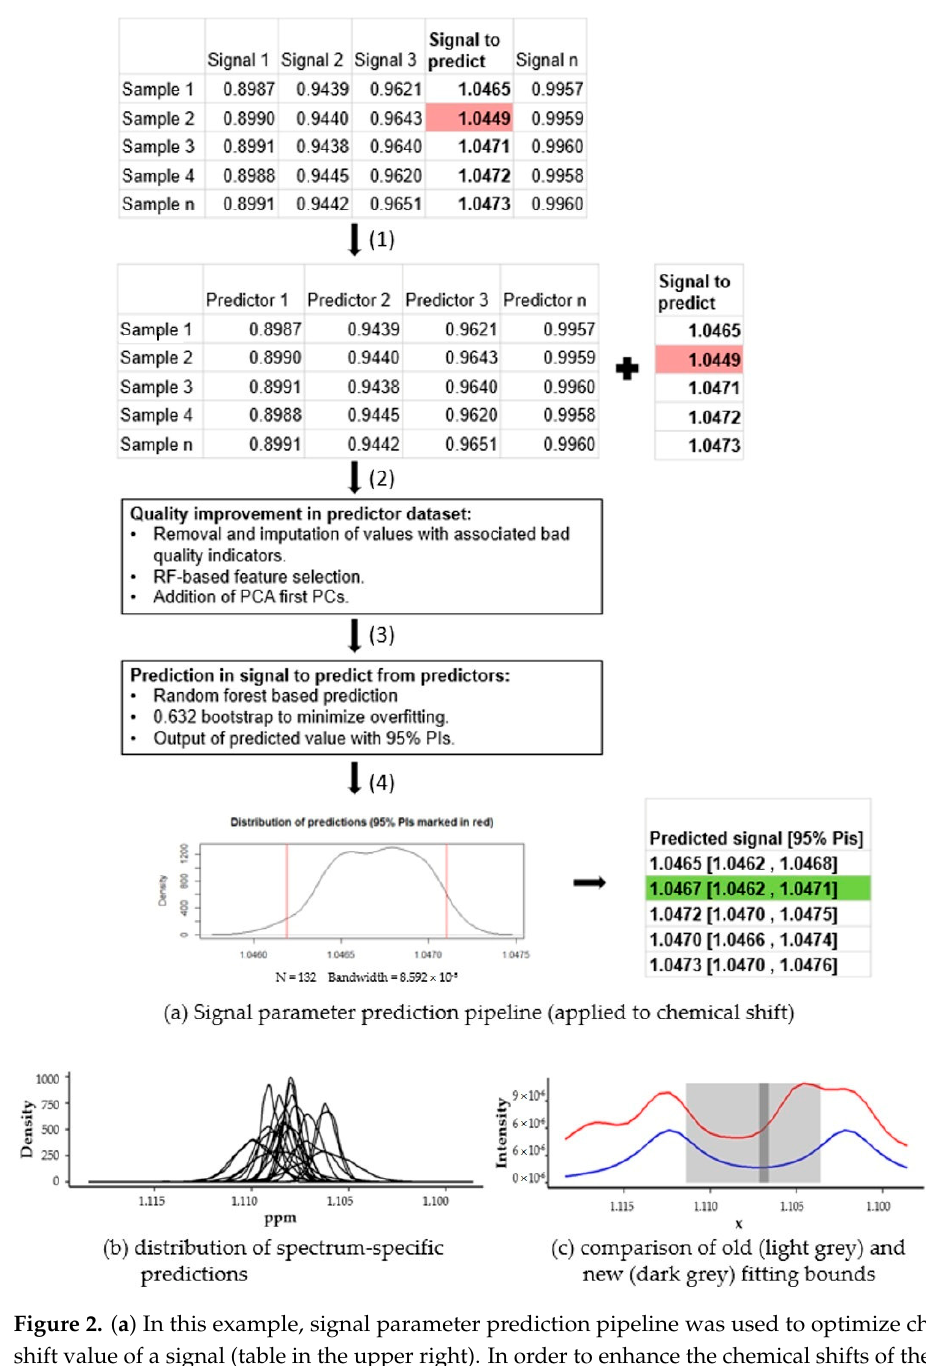
Figure 2. ( a ) In this example, signal parameter prediction pipeline was used to optimize chemical shift value of a signal (table in the upper right). In order to enhance the chemical shifts of the signal in question, a training dataset was built, excluding the signal to predict ( a , 1 ). The dataset is then cleaned, filtered, and enriched to maximize its prediction quality ( a , 2 ). The information from the first iteration was used to train a prediction model. During training, bootstrap resampling was used to avoid overfitting inaccurate values ( a , 3 ). For each predicted chemical shift, the distribution of the predictions made during the bootstrap iterations was built and the median value and 95% PIs of this distribution were outputted ( a , 4 ). After optimization, the predicted value and PIs are shown in the bottom right table; in this case, an inaccurate chemical shift, shaded in red, was clearly outside the 95% PIs, shaded in green. ( b ) shows the distributions of chemical shift predictions generated. These distributions were very narrow and could help generate even narrower chemical shift ranges (dark grey rectangle) than those originally needed without machine learning prediction (light grey rectangle) ( c ).